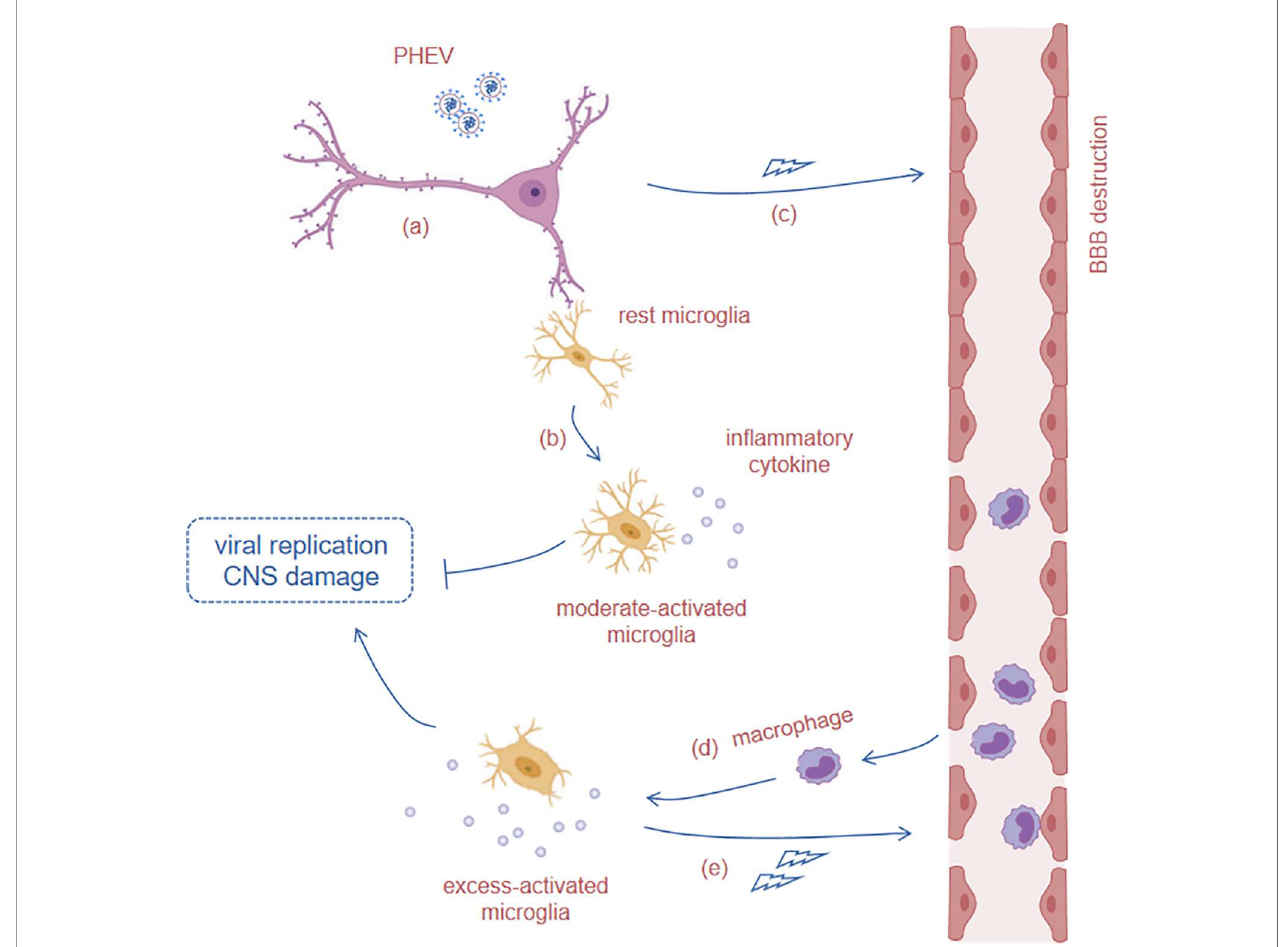
FIGURE 6 | Microglial response acts in PHEV infection. PHEV infects neurons in the CNS, which release progeny virus and signaling molecules into the microenvironment. (a) PHEV infects neurons in the CNS. (b) In response to the signal of CNS infection, resting microglia are moderately activated and produce in fl ammatory cytokines to restrict viral replication at the early stage (1 to 4 dpi). (c) Meanwhile, rapid viral replication increases the permeability of BBB and recruits circulating monocyte/macrophage to cross the BBB. (d) BBB destruction portends the late stage of PHEV infection (5 to 7 dpi), and the in fi ltrated monocytes/macrophages contribute to the excess activation of microglia and production of large amounts of in fl ammatory cytokines. (e) Excess microglial activation and in fl ammatory cytokines secretion further aggravate BBB destruction, thereby promoting peripheral monocyte/macrophage in fi ltration and CNS